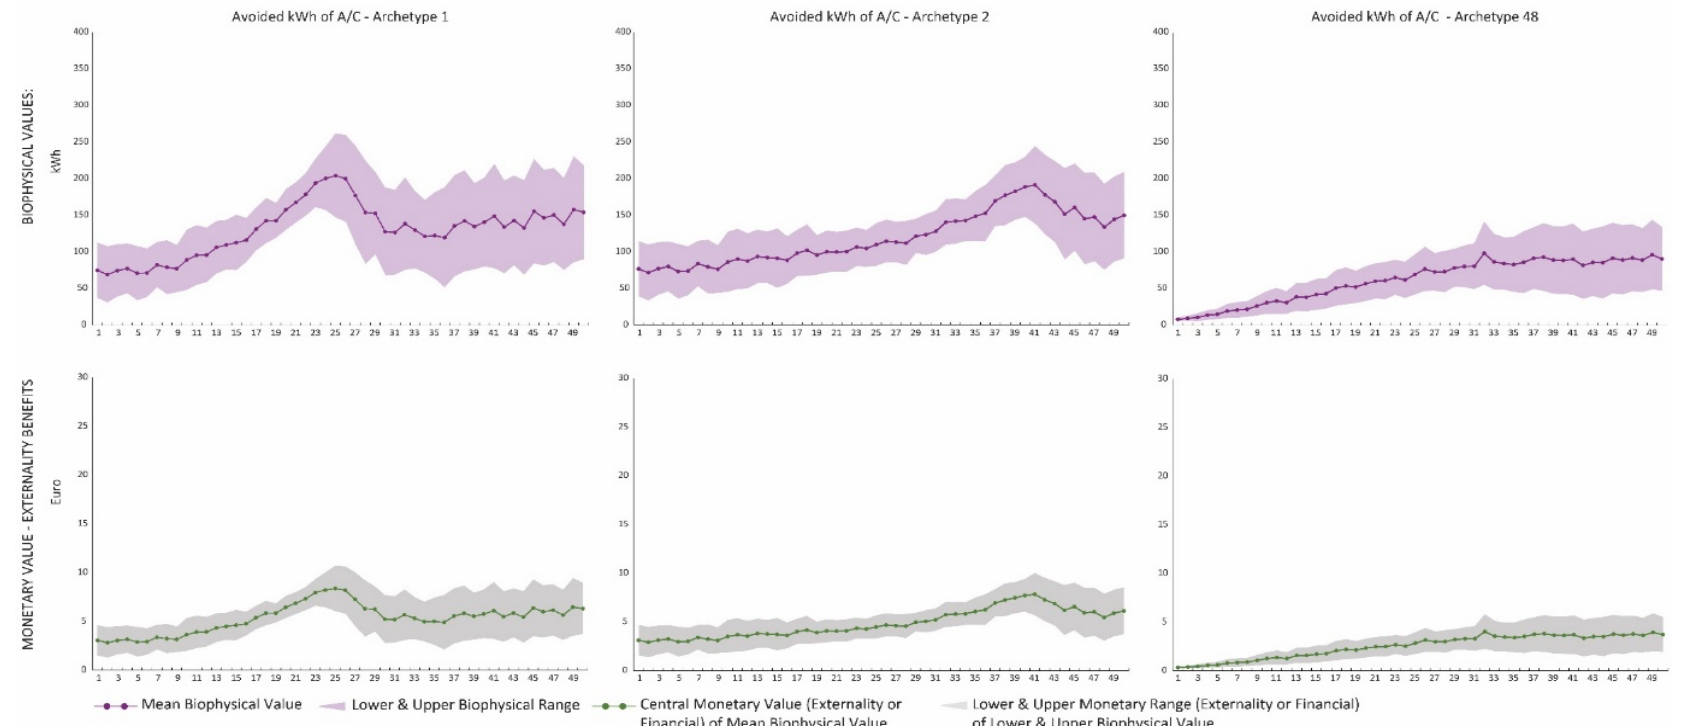
Figure 13. Comparison of biophysical and monetary performance over time for “Regulation of temperature and humidity” in archetypes 1, 2, and 48. Results are shown as non-cumulative values (i.e., values represent the ones produced each year) to illustrate more clearly that this ecosystem service is not continuously increasing over time.